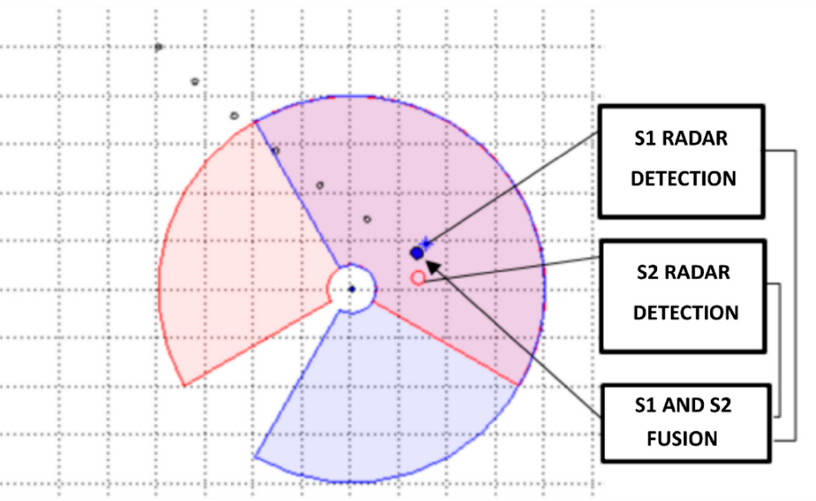
Figure 8. Geometrical interpretation of the case of multiple radar detection of the same object.